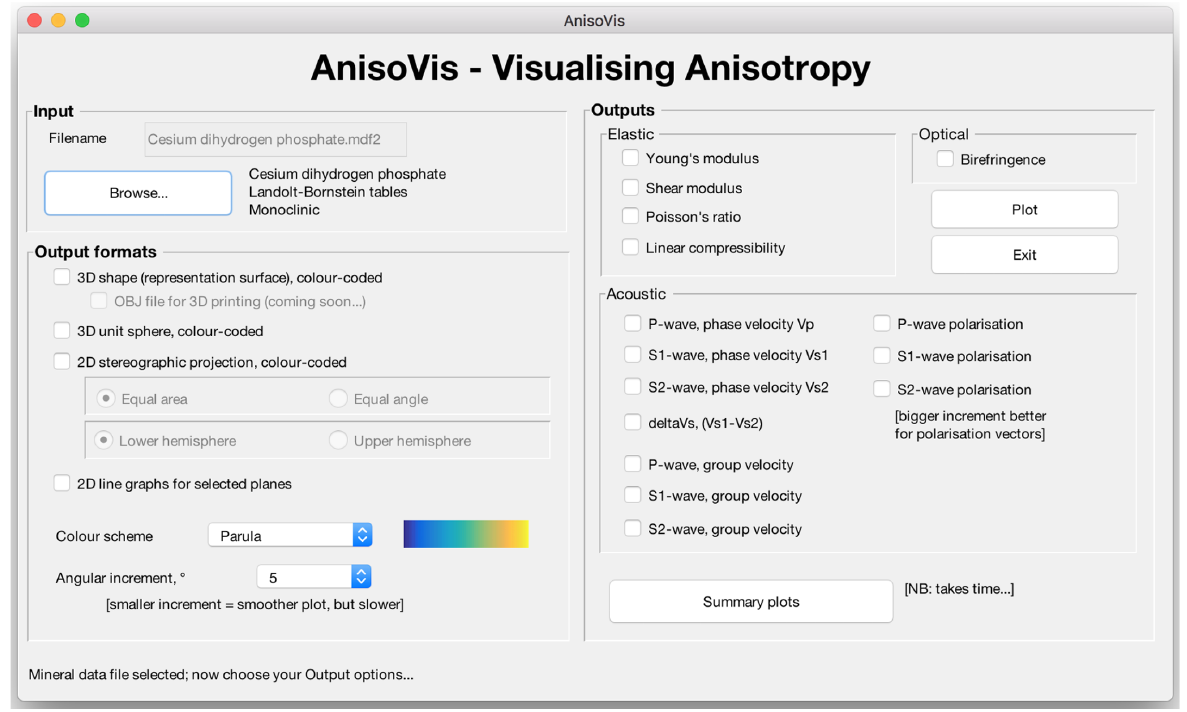
Figure 2. The graphical user interface in AnisoVis, showing the range of output options for elastic, acoustic and optical anisotropies.